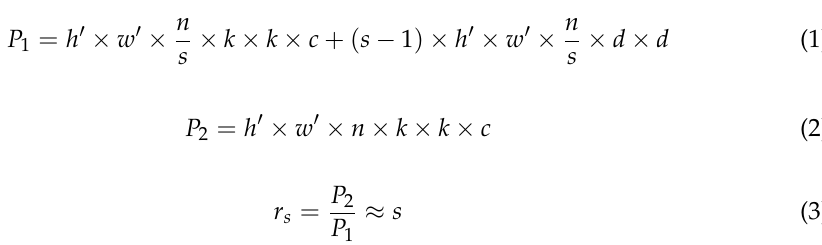
Figure 6. ( a ) CBM module ( b ) CBL module ( c ) GBM module ( d ) SPP module.